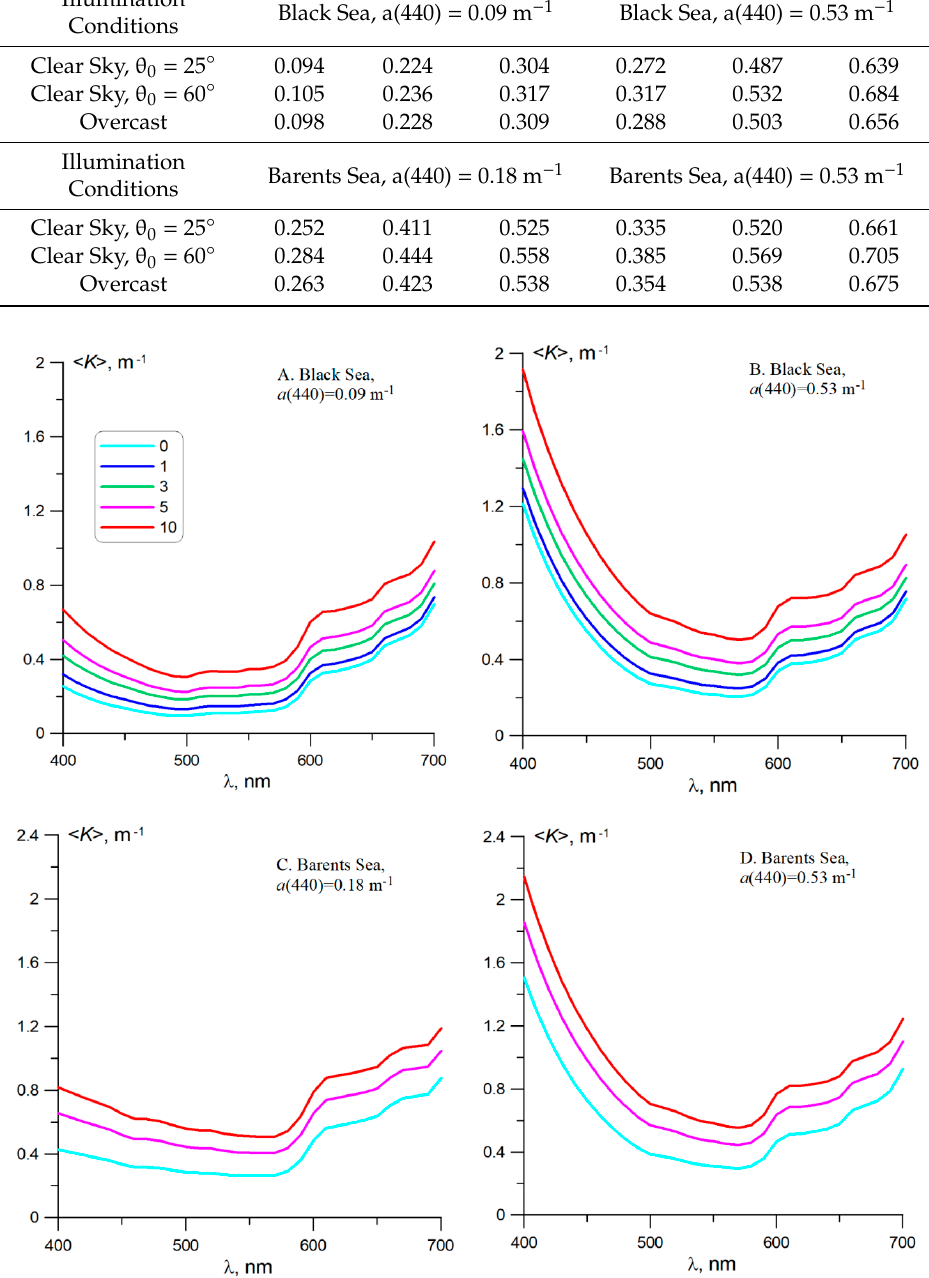
Figure 12. The results of model simulation of the diffuse attenuation coefficient < K > for the photic layer as a function of N coc (10 6 cell/L) and the absorption coefficient a (440). The cases ( A , B) are calculated for the Black Sea and θ 0 = 25°; ( C , D ) For the Barents Sea and θ 0 = 60°.